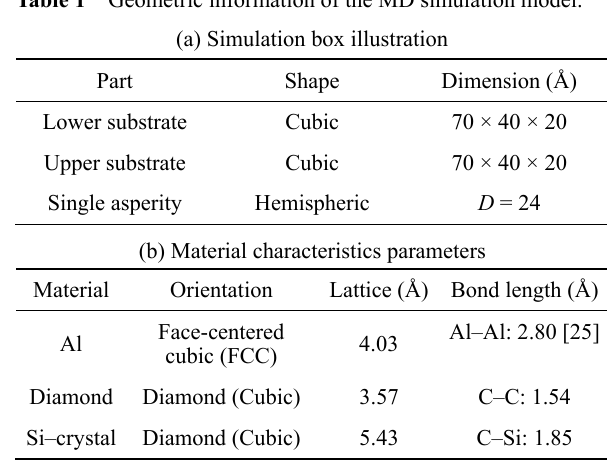
Table 1 Geometric information of the MD simulation model.